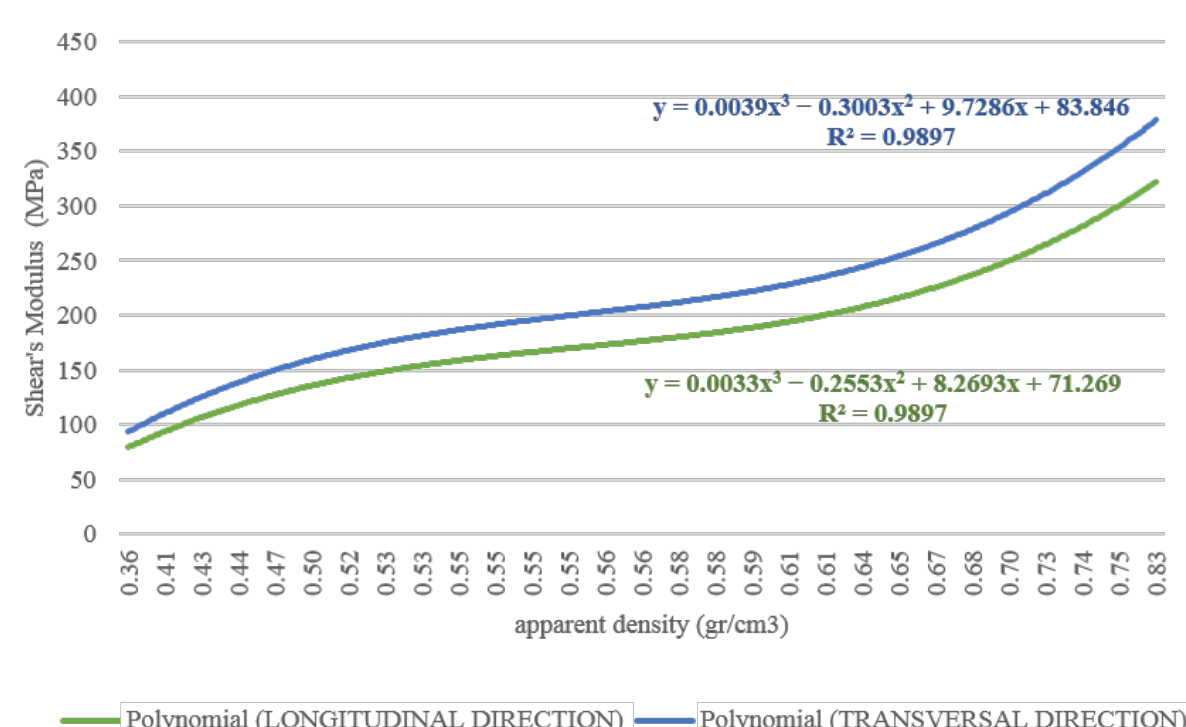
Figure 9. Relationship between apparent density and Shear’s modulus for trabecular tissue affected with OI in the longitudinal and transversal direction.